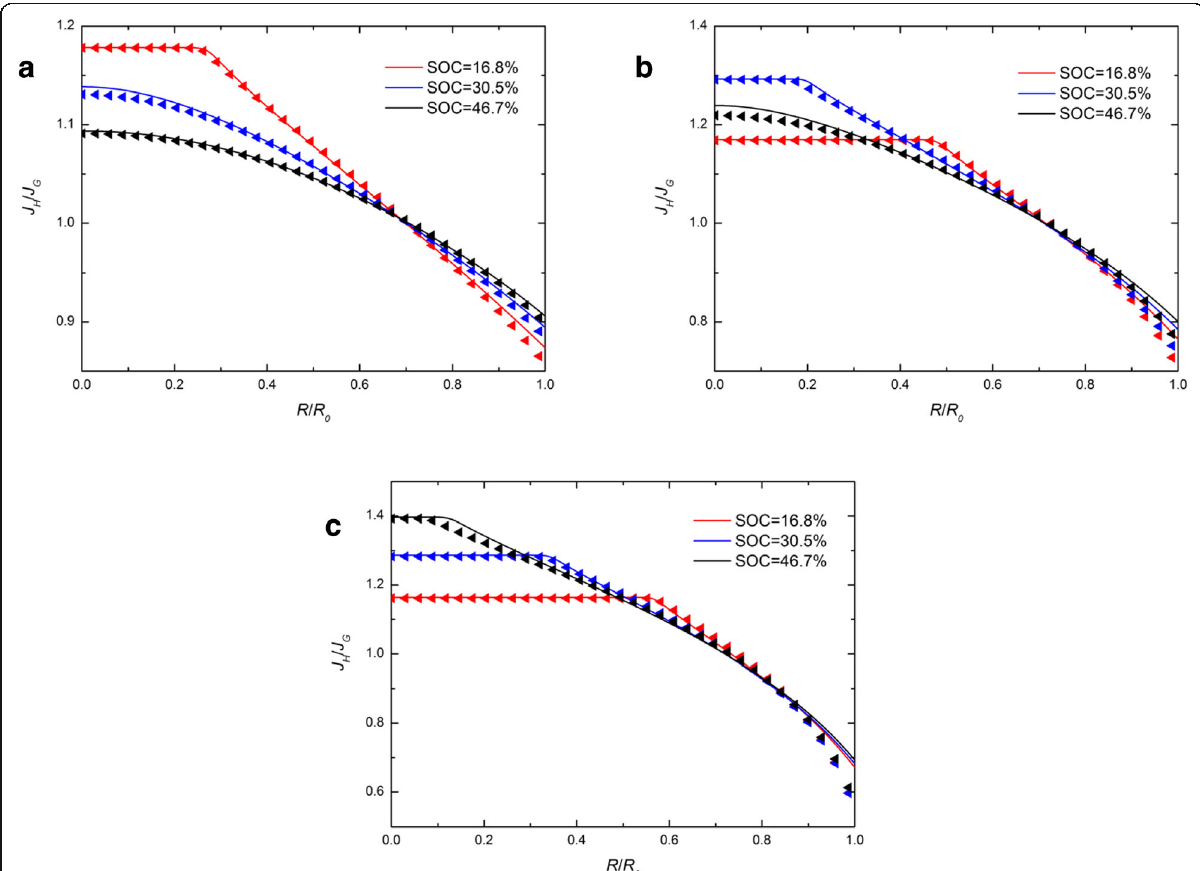
Fig. 4 Spatial distribution of J H / J G in a spherical Si nanoparticle electrode at different SOCs under galvanostatic operation with ( a ) j = 0.5 j 0 , ( b ) j = j 0 , and ( c ) j = 1.5 j 0 (solid lines represent the results with the traditional expression of chemical potential; triangles lines represent the results with the developed expression of chemical